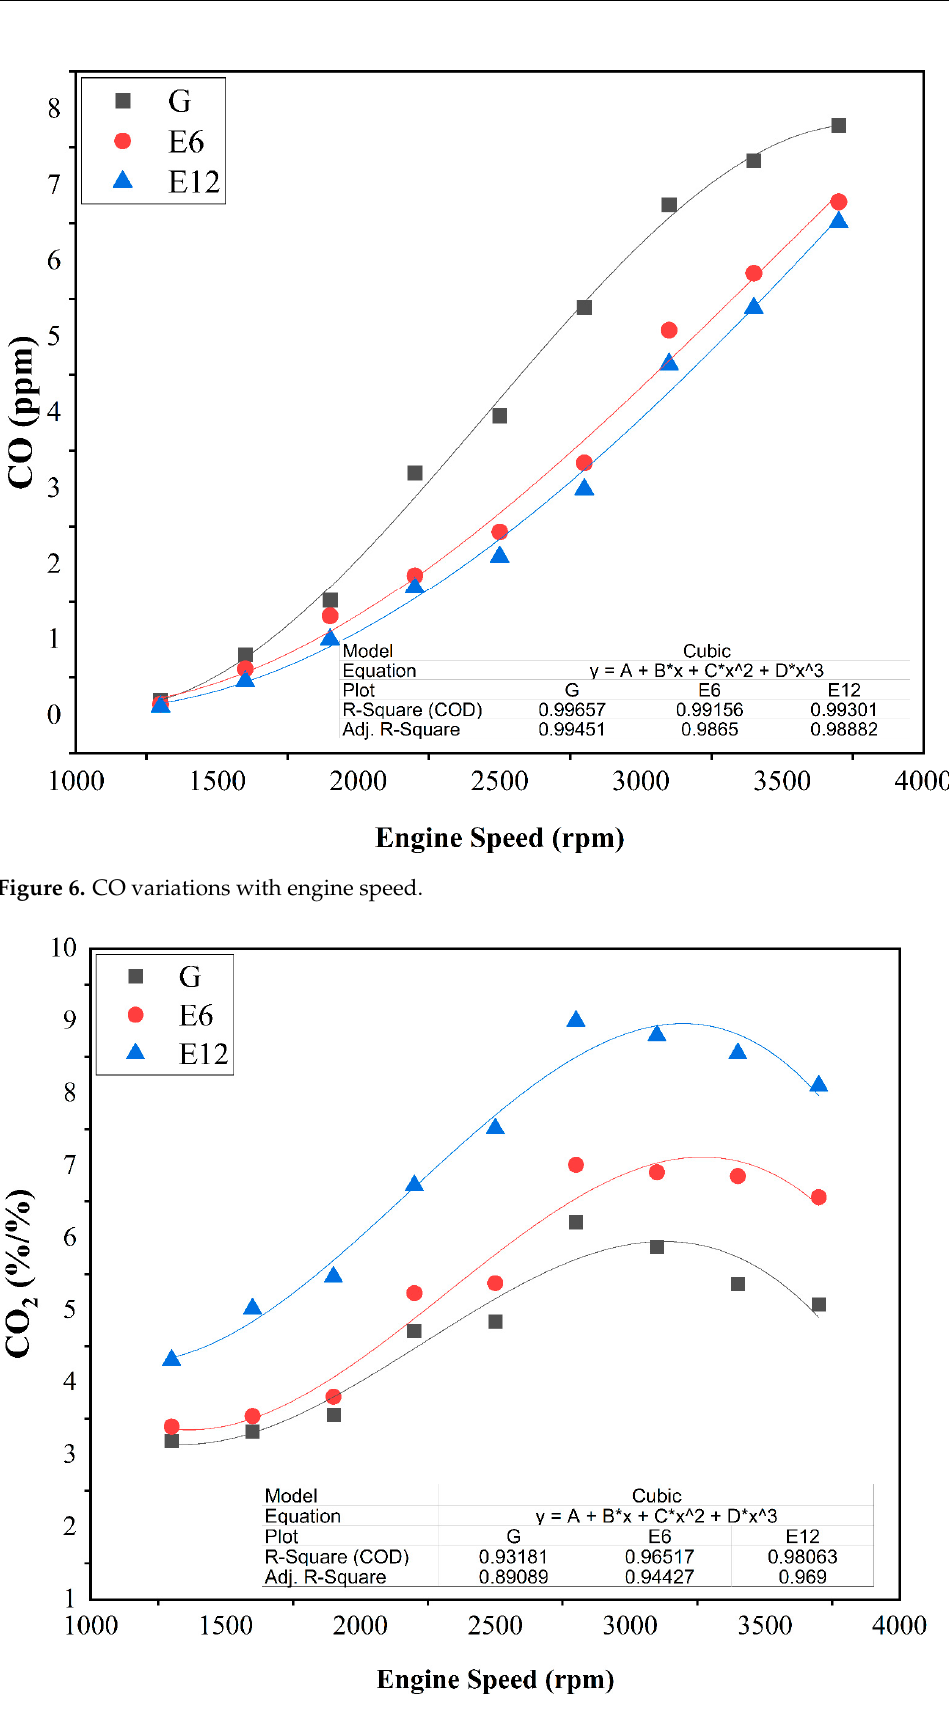
Figure 7. CO 2 variation with engine speed .